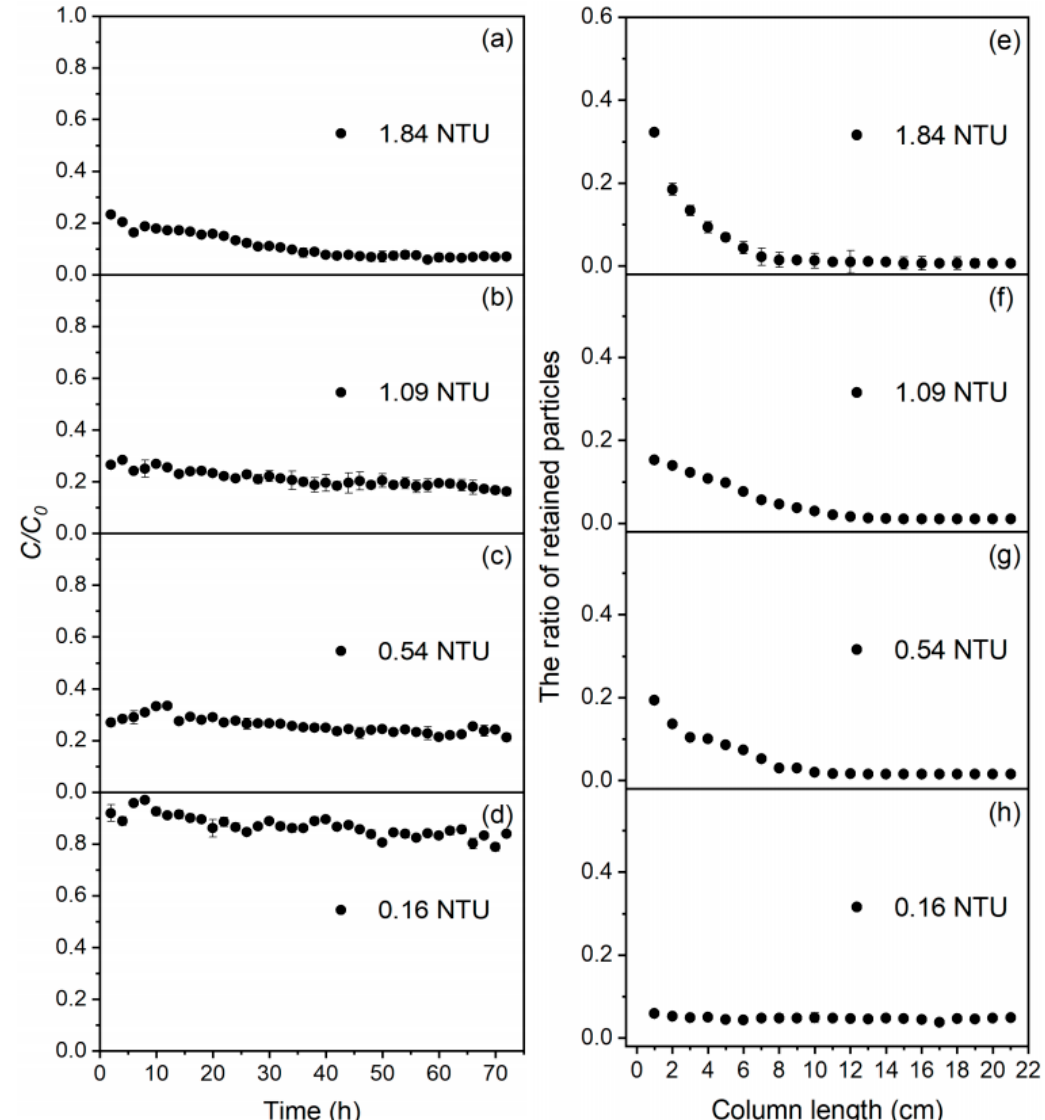
Figure 3. Breakthrough curves ( a – d ) and retained particle ratios ( e – h ) for four sets of experiments. C / C 0 : normalized effluent concentration.